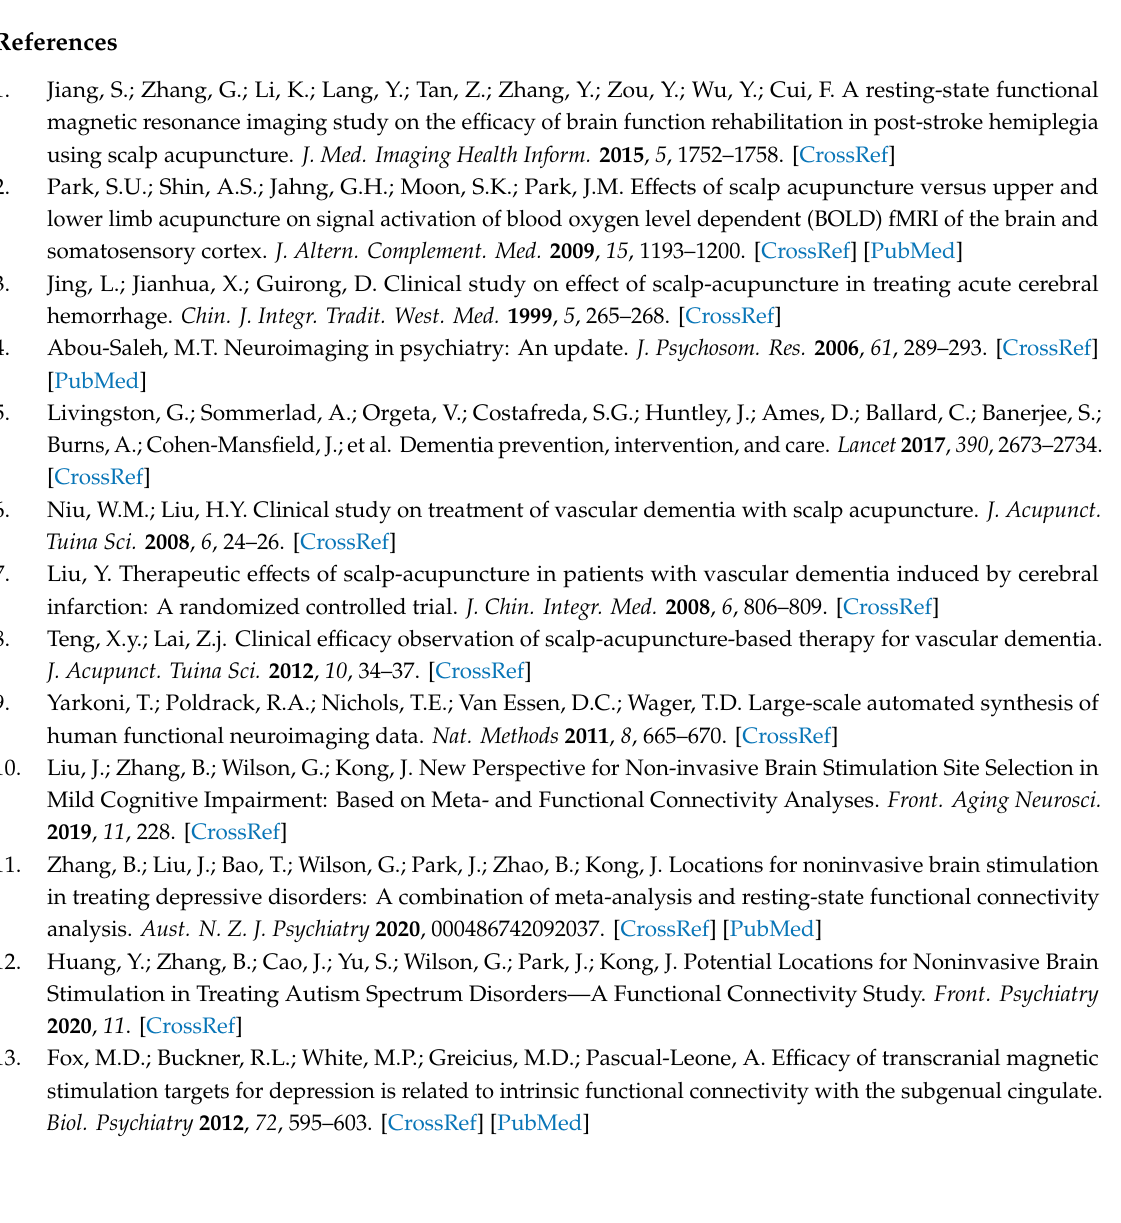
Table S1: List of 142 studies extracted from Neurosynth under search term “dementia” on April 16, 2020; Table S2: Coordinates of dementia-associated regions identified from